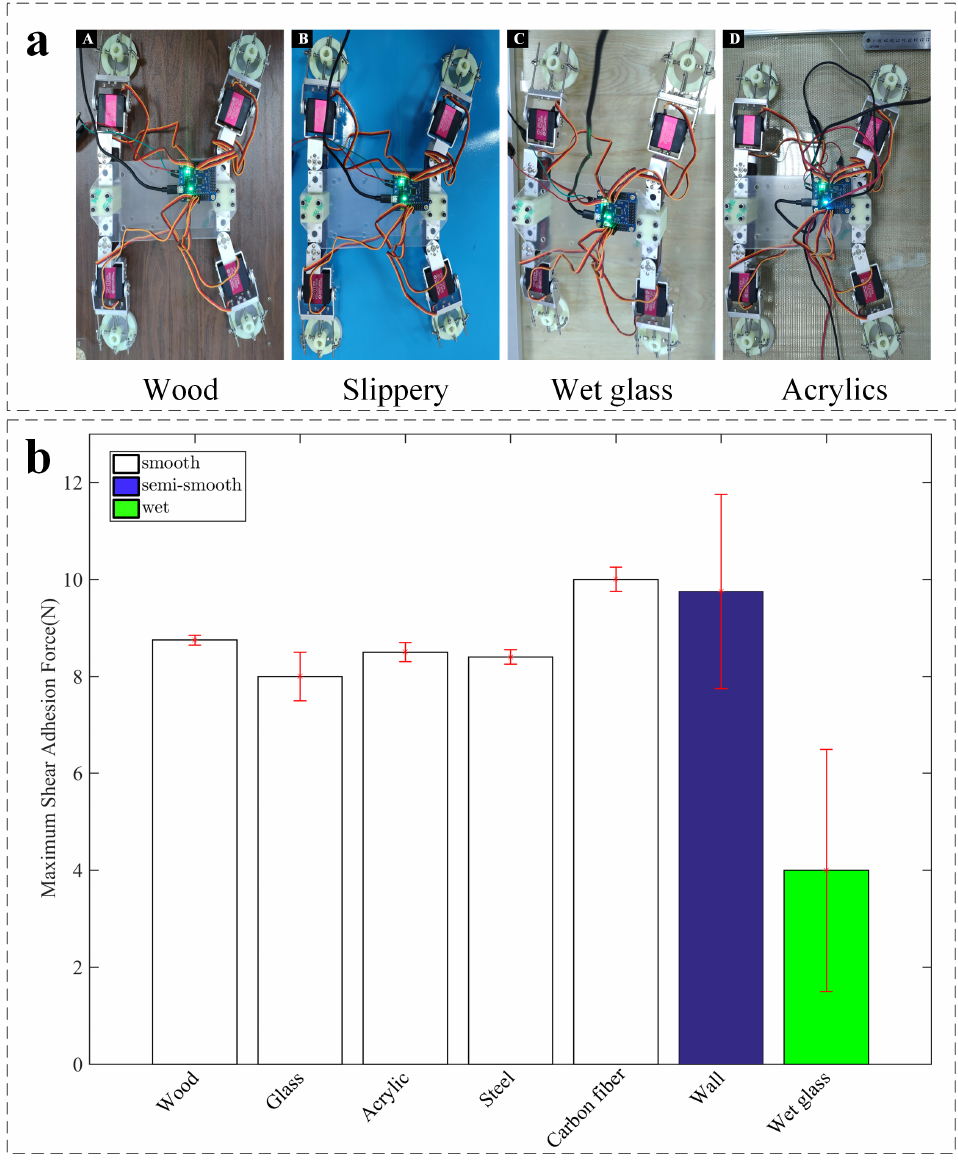
Figure 11. Characterization of adhesion force and demonstration of inclined crawling of robot on different substrates. ( a ) demonstration of the robot’s wide capability of climbing on different types of inclined surfaces with a carried 500 g load, ( A ) wood, ( B ) slippery steel, ( C ) wet class, ( D ) acrylics. ( b ) Results of the measured maximum shear adhesion force on different types of